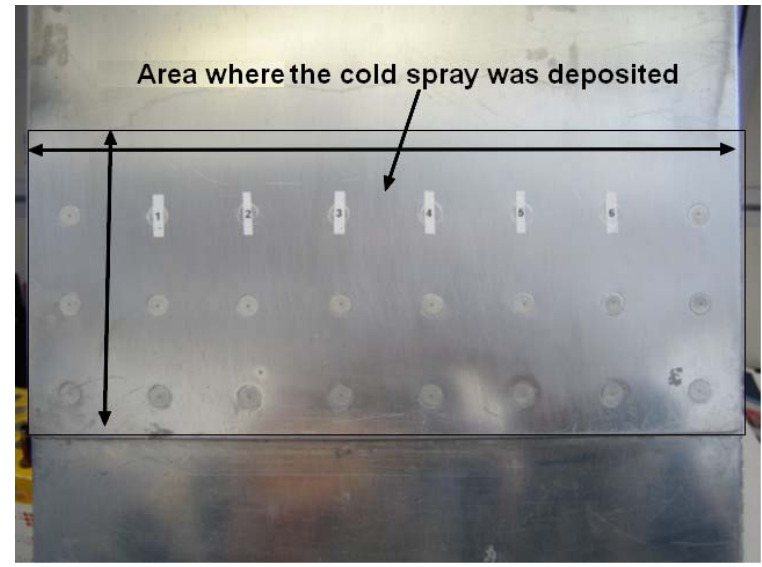
Figure 16. Plan view a fuselage lap joint specimen panel and fastener numbers showing the area over which the cold spray was deposited; from [93].